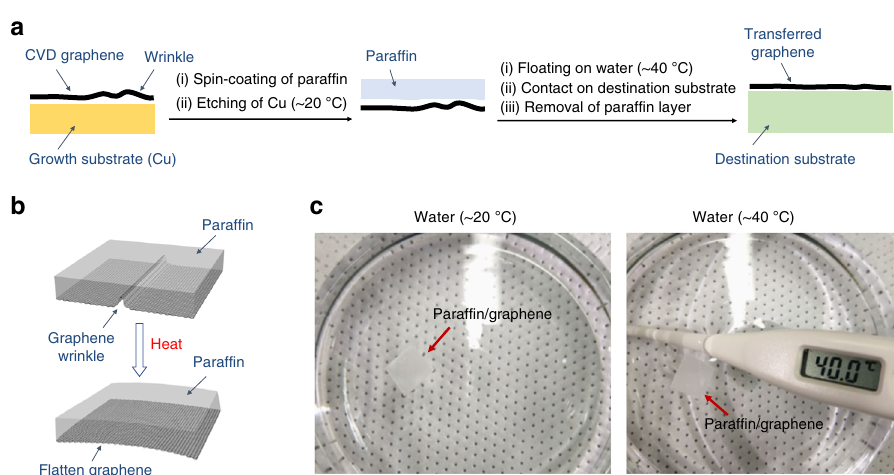
Fig. 1 Our paraf fi n-enabled graphene transfer method. a Schematics showing the process of paraf fi n-assisted graphene transfer. b Schematics showing the effect of paraf fi n ’ s thermal expansion on graphene wrinkle. c Photographs of a typical paraf fi n-supported graphene fi lm fl oated on water at different temperatures as indicated con fi rming that the paraf fi n layer is still in solid state at ~40